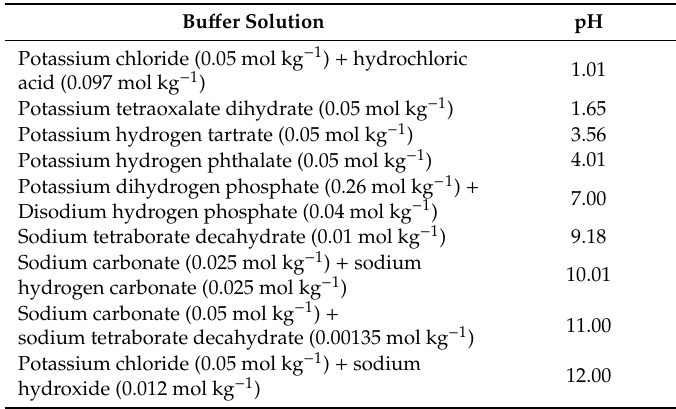
Table 5. Composition of bu ff er solutions used to prepare colorimetric scales of